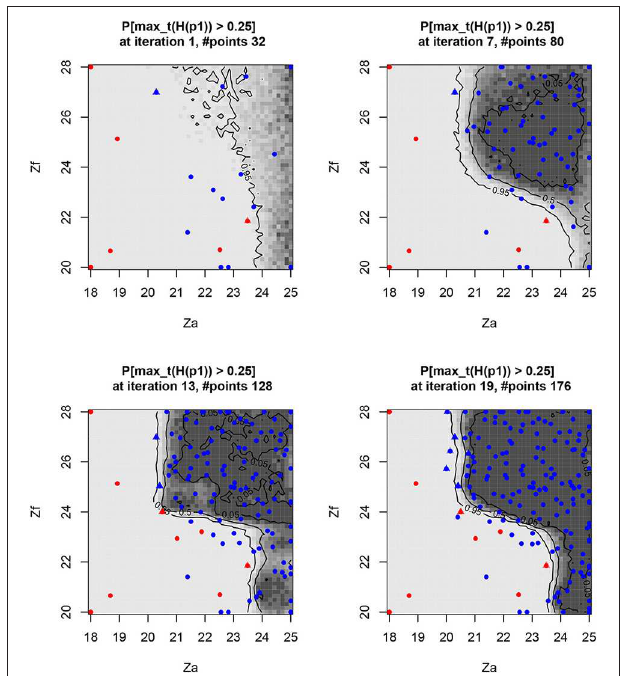
FIGURE 6 | Probability of exceeding the level of 25 cm on the slab, depending on the controlled Z a and Z f parameters, along some RSUR iterations (last added points as triangles, exceeding the points in red). The fairly dense sampling of the “safe” zone represents a practical safety